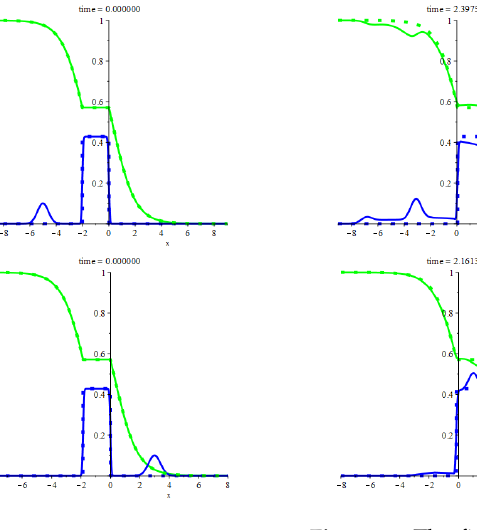
Figure 3. The figure illustrates the evolution of the initial perturbations described in clauses (c) and (d) on page 10. In particular, the bottom row demonstrates the leapfrog playing. The detailed description of the initial states and all other settings used for computing this figure is in Appendix A.